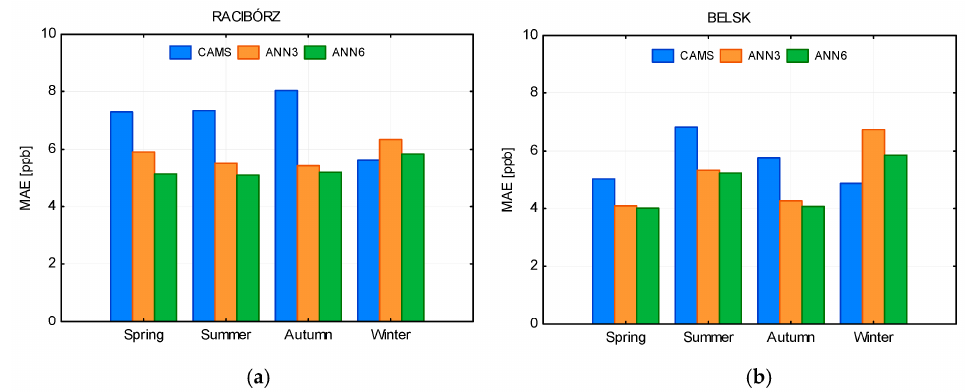
Figure 14. MAE for the best CAMS forecast, ANN3 and ANN6 for Racibórz ( a ) and Belsk ( b ).